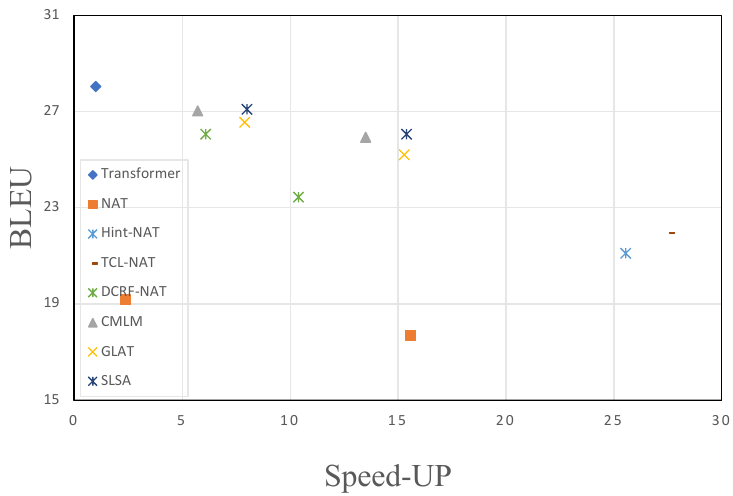
Figure 2. The balance of performance and speedup on the EN →